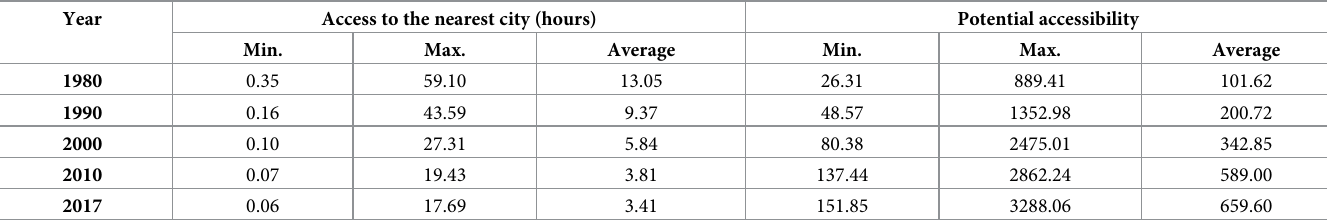
Table 1. Transport accessibility between townships and major